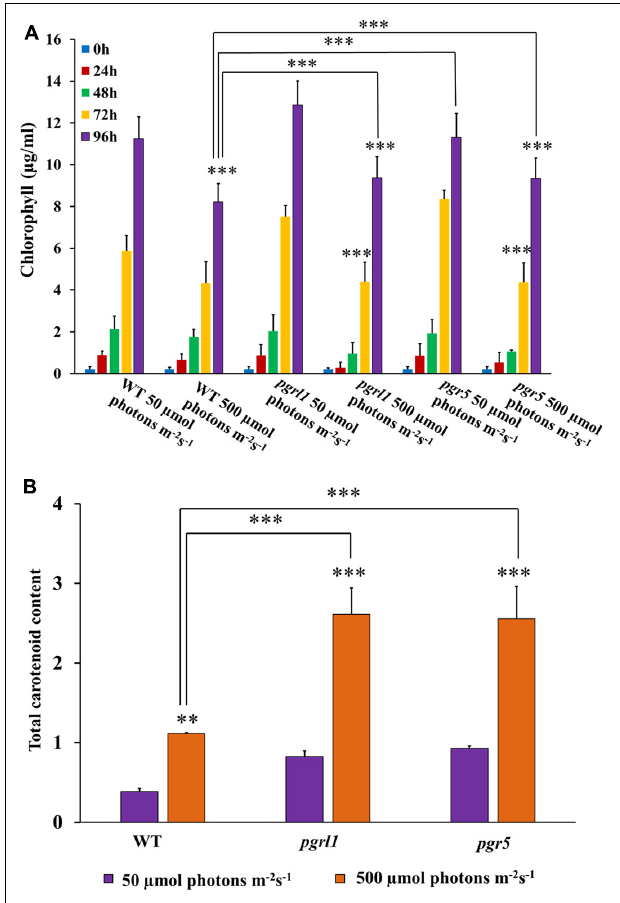
FIGURE 2 | Chlorophyll and carotenoid content were quantified from cells grown under normal and high light conditions. (A) Chlorophyll content was quantified from 50 µ mol photons m − 2 s − 1 and 500 µ mol photons m − 2 s − 1 conditions with different time intervals of 24, 48,72, and 96 h. (B) Total carotenoid content from the cells grown under normal and high light conditions. Carotenoids were calculated from cells grown with control WT and mutant pgrl1 and pgr5 cells grown from normal light (50 µ mol photons m − 2 S − 1 ) and high light condition (500 µ mol photons m − 2 S − 1 ) measured after 3rd day. Three biological experiments were done, n = 3. Statistical significance was analyzed using one-way ANOVA with Tukey test and p -value indicated as ( ∗∗∗ p < 0.001, ∗∗ p <